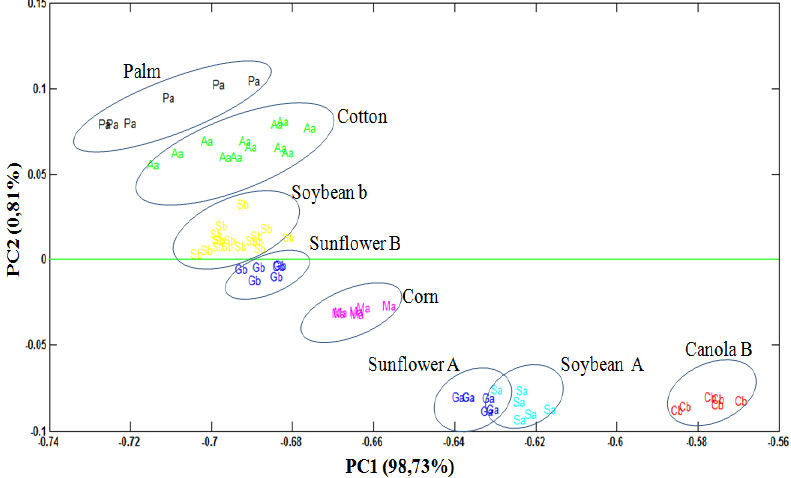
Figure 6. i PCA scores plot (PC1 versus PC2) for the UATR-FTIR spectra of biodiesel